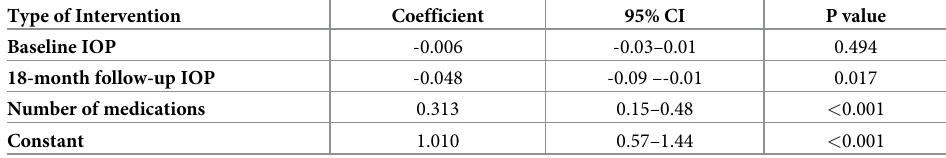
Table 3. Results of multivariable random coefficient model analysis of type of intervention, baseline IOP and 18-month follow-up IOP, including the covariable of number of medications.